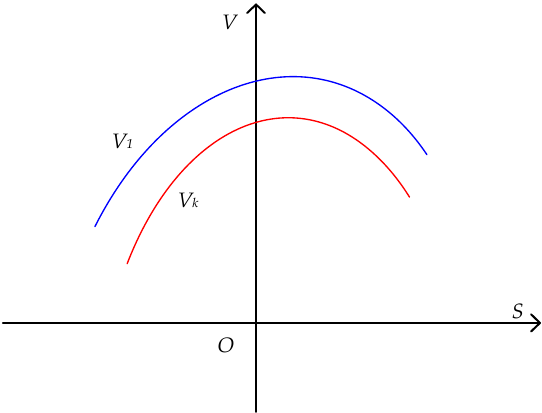
Figure 2. Comparison of social welfare function V.